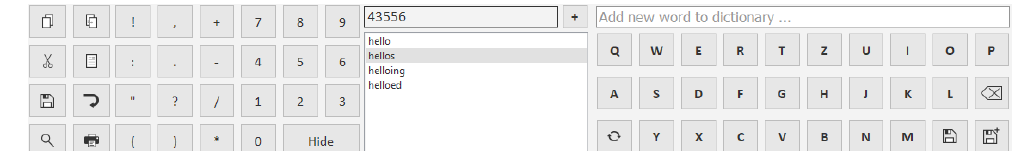
Figure 10. User interface of the desktop application with the extended on-screen keyboard on the right to add new words to the dictionary. Shortcuts are accessible through the first two columns, while the following six columns contain special characters and numbers. The middle section is used to display the entered keyboard input on top and to list the word suggestions in the white box